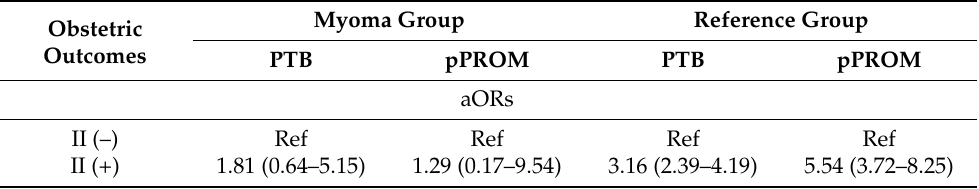
Table 3. Adjusted odds ratios for PTB and pPROM in women with